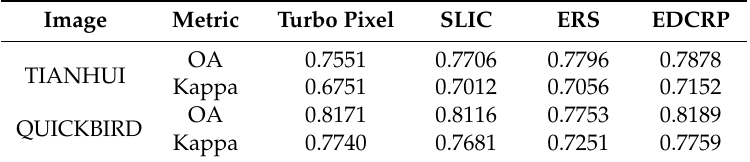
Table 6. The Overall Accuracy (OA) and kappa of the classifier over both the TIANHUI and QUICKBIRD images.